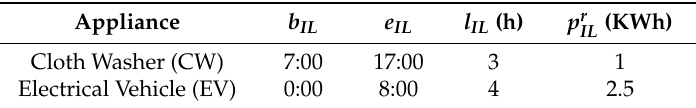
Figure 1. ( a ) Power output of the photovoltaic generation and power consumption of the uncontrollable loads for the next day; and ( b ) the real-time price for the next day. Table 1. Parameters of interruptible loads.